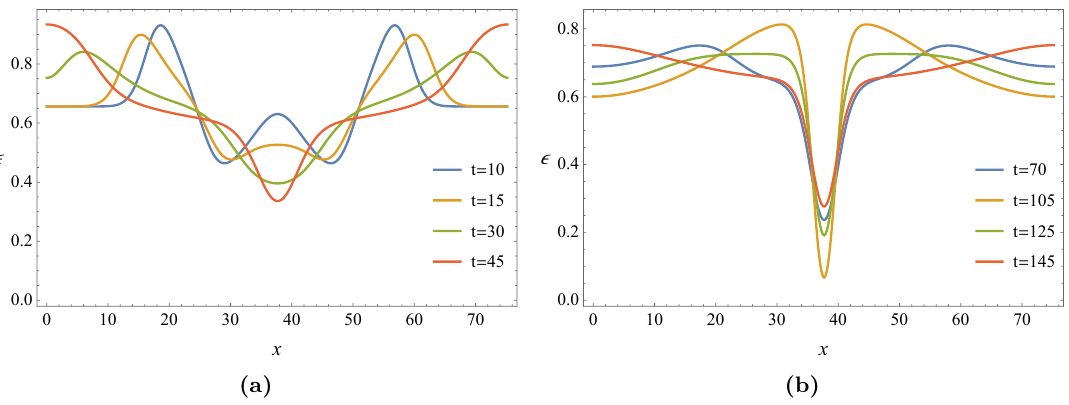
Figure 8. (a): merger of inward waves and damping of outward waves until t ≈ 30 ; the formation of critical nuclei and injection of outward waves around t ≈ 45 . (b) Two damping waves hit the domain wall around t ≈ 105 , and subsequently bounce